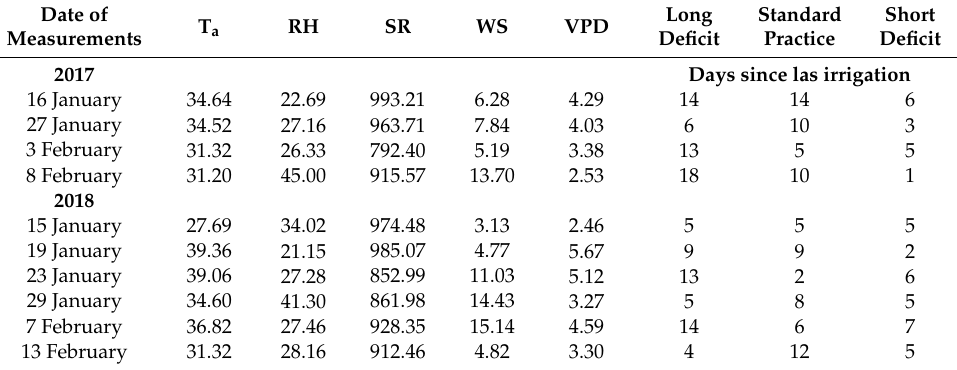
Table 2. Dates when multispectral and thermal images of the site were taken with the average values for air temperature (T a , ◦ C), relative humidity (RH, %), solar radiation (SR, W m − 2 ), wind speed (WS, km h − 1 ) and vapor pressure deficit (VPD, kPa) averaged from 11 h to 15 h. The number of days since the last irrigation event for each treatment and measurement date are also